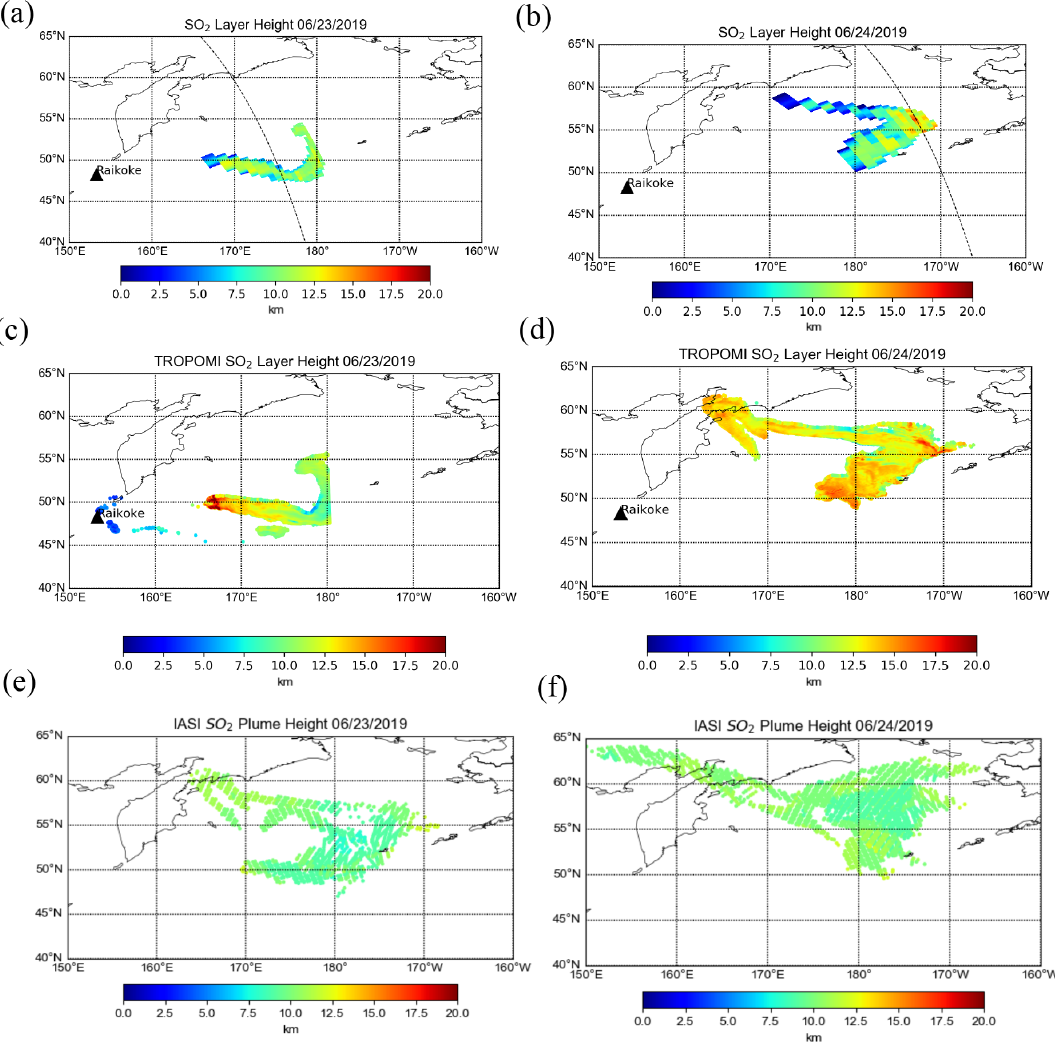
Figure 9. The SO 2 layer height retrieval for the Raikoke eruption plume on 23 June 2019 (a, c, e) and 24 June 2019 (b, d, f) for OMI (a, b) , TROPOMI (c, d) , and IASI (e, f) . For all three sensors, only pixels for which SO 2 VCD > 30DU are